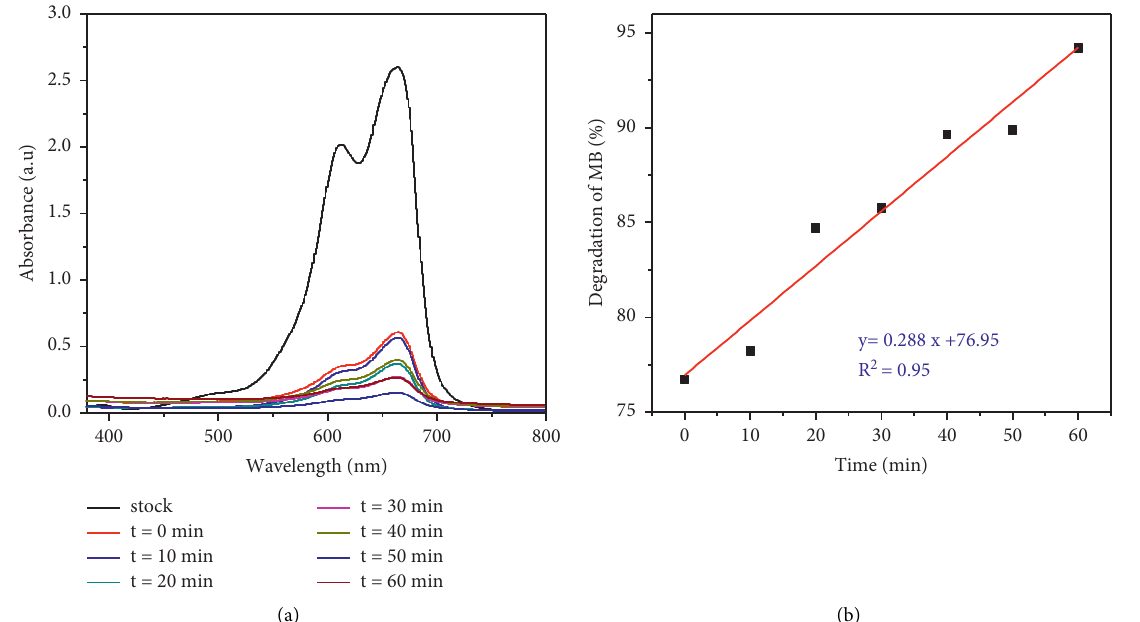
Figure 14: Effect of contact time (a) and % of degradation (b) on the degradation of MB using optimized CS peel extracts template TiO 2 /rGO-1.5c NCs green